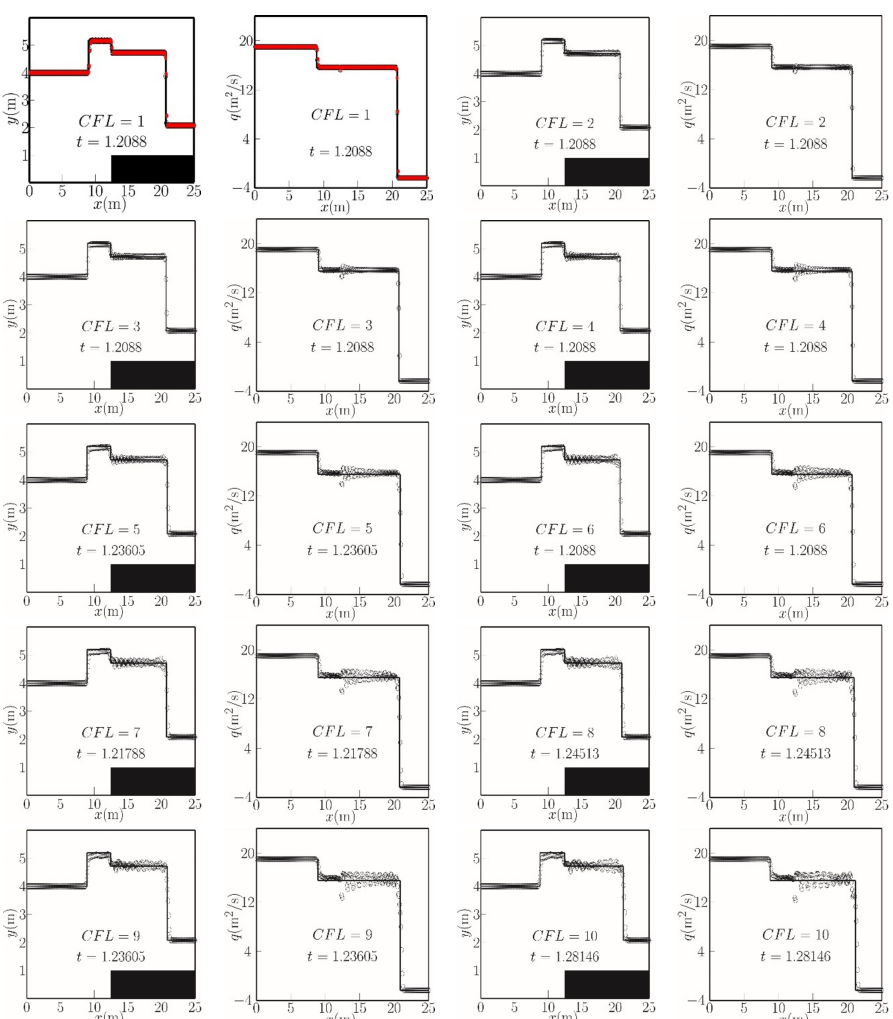
Figure 5. Free surface and mass flux profiles for two shocks in a channel containing a bed step at a given time instant. Rosatti and Begnudelli [23]’s analytical solution (solid lines), well-balanced scheme [22] (red circles), and TVD-LTS predictions (open circles) for CFL = 1 to 10. The solid rectangle indicates the bed